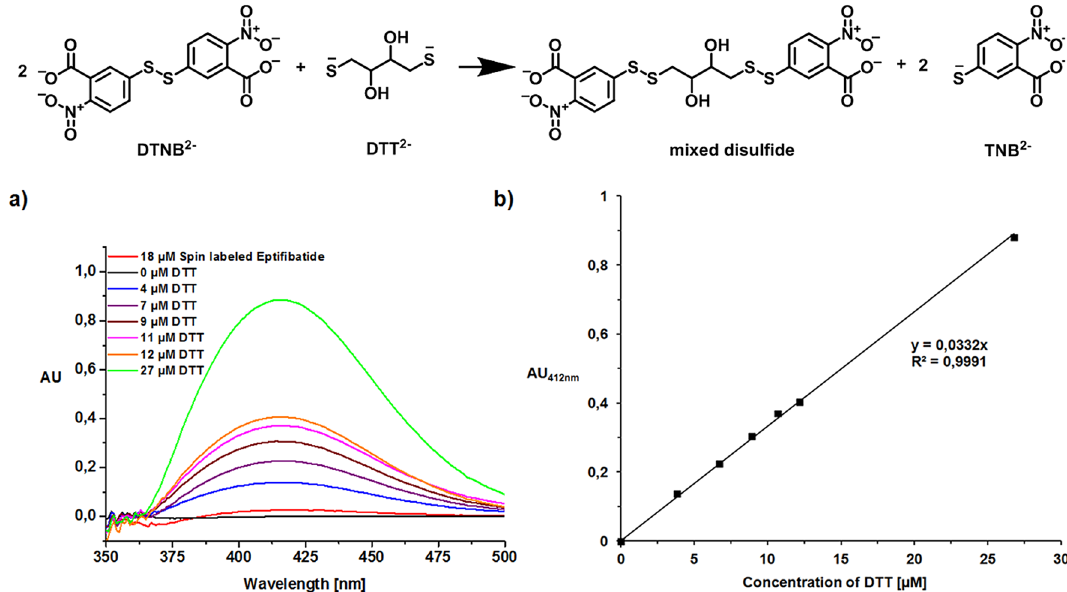
Figure 3. Reduction of Ellman’s reagent (DTNB) with dithiothreitol (DTT) (above). (a) Dithiothreitol (DTT) concentration dependent UV-spectra and the UV-spectrum of eptifibatide in the presence of Ellman’s reagent (DTNB). (b) Calibration curve of the absorbance UV light at 412 nm with known concentrations of dithiothreitol (DTT) after reduction reaction with Ellman’s reagent (DTNB).